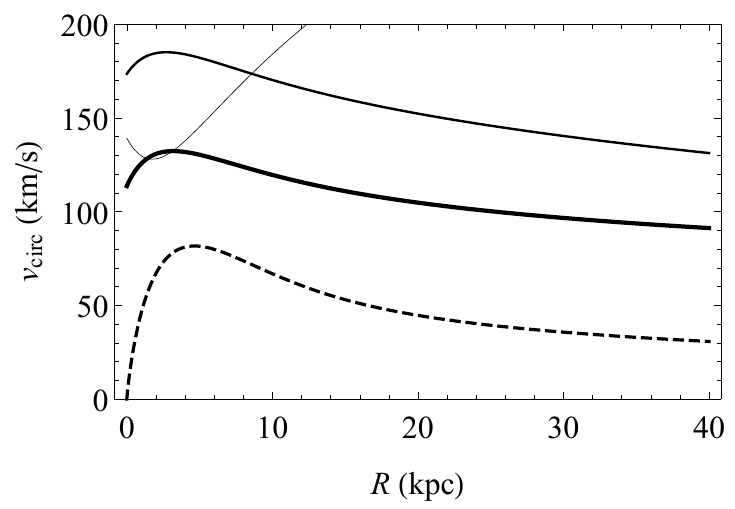
Figure 2 . Rotation curve of baryonic matter in the thin-disk approximation and an exponential matter density profile in Einstein’s theory (eq. (A.34), dashed curve) and in the multi-fractional theory T with weighted derivatives in the extreme fractional limit ((4.46), (4.47) or (4.48), and v eqs. (4.49), where α < 1 and R (cid:28) R ) for α = 0 . 4 , α = 2 / 3 and α = 0 . 8 (solid curves of increasing ∗ thickness). Here M = 1 . 72 × 10 40 kg , R = 2 . 16 kpc and R = 40 kpc 0 ∗